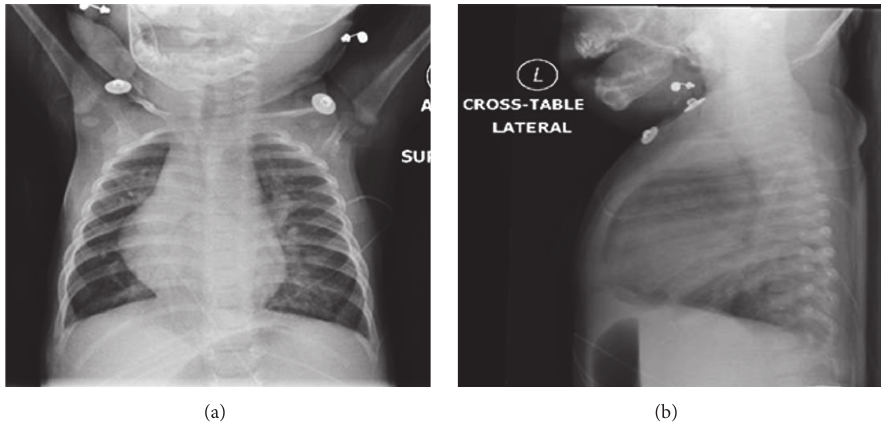
Figure 1: Initial CXR: enlarged cardiac silhouette, with increased interstitial markings (suspected to be from pulmonary edema secondary to left-to-right shunt due to PDA or from a viral process).